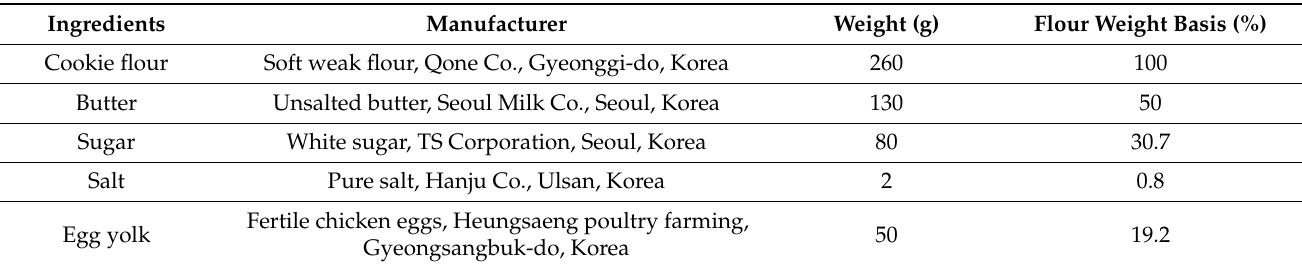
Table 2. Basic formulation for the preparation of sugar